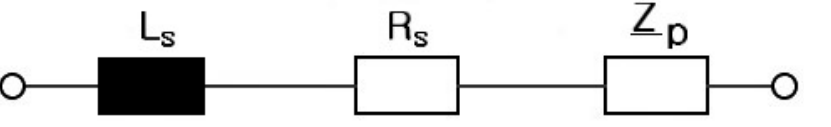
Figure 9. Impedance spectrum according to temperature of the supercapacitor [5,6].